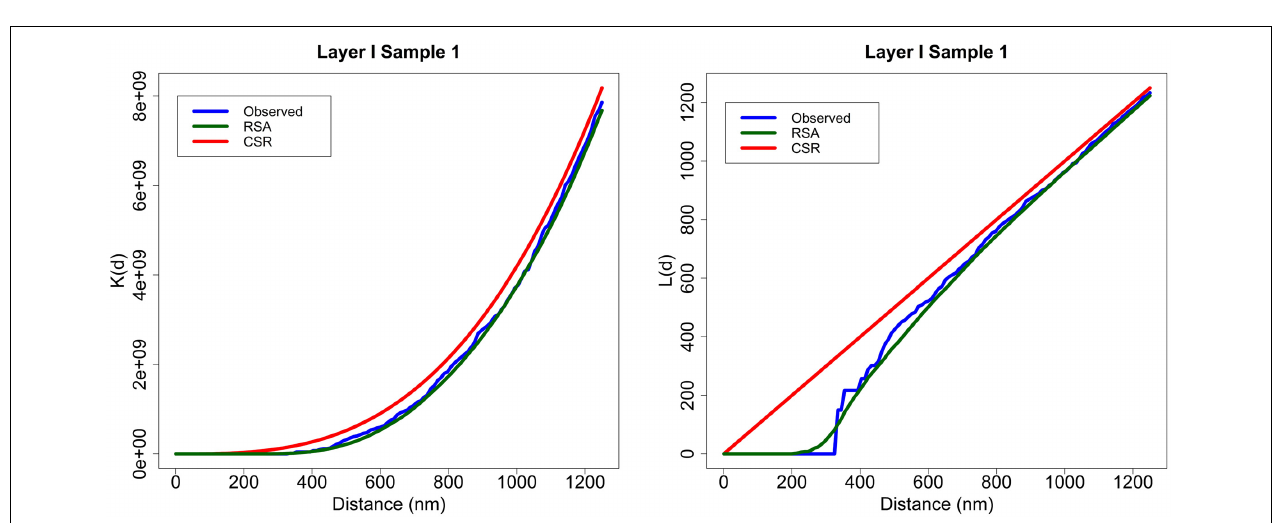
FIGURE 2 | Layer I, Sample 1. An example of K and L functions for CSR and RSA processes. K (left) and L (right) functions of the experimentally observed data (blue) along with the theoretical CSR (red) and the average of 99 RSA process simulations fitted for sample 1 (green). The K functions of the